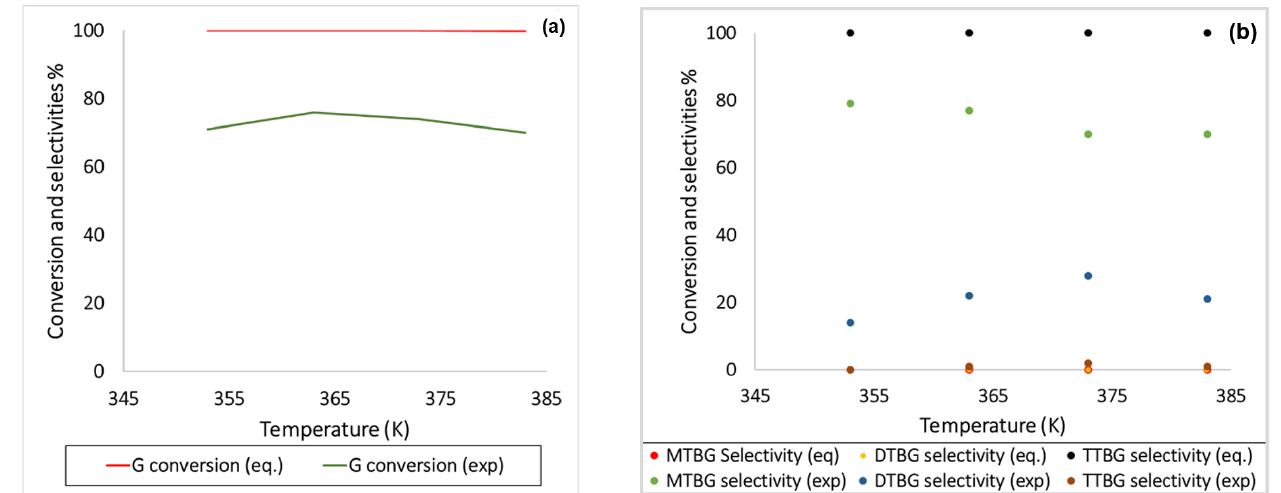
Figure 19. Experimental and equilibrium values of, ( a ) Glycerol conversion as a function of temperature, ( b ) Component selectivity as a function of temperature.